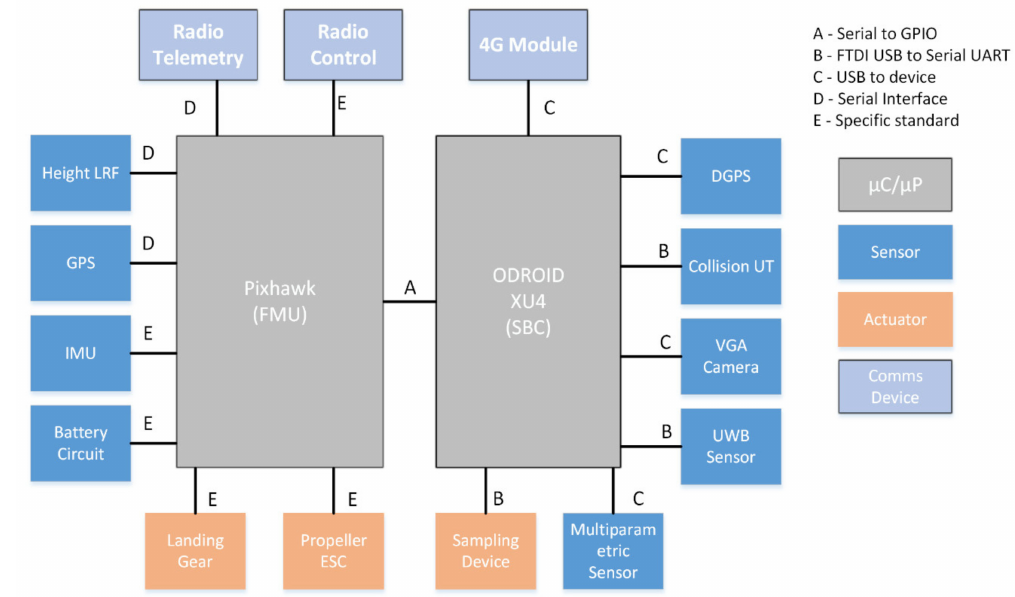
Figure 4. Hardware integration schema for the prototype UAV platform built. Only the sample capture device or the multiparametric probe will be deployed at any given time. DGPS integrated only for testing and evaluation of localization approaches. ESC, electronic speed control; FMU, flight management unit; LRF, laser range finder; SBC, single board